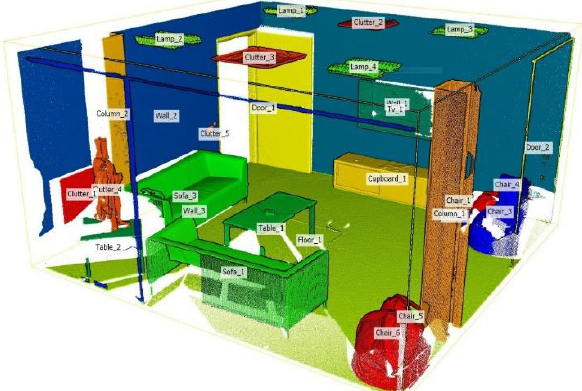
Figure 3. Classification results: a piece with different objects and their labels.